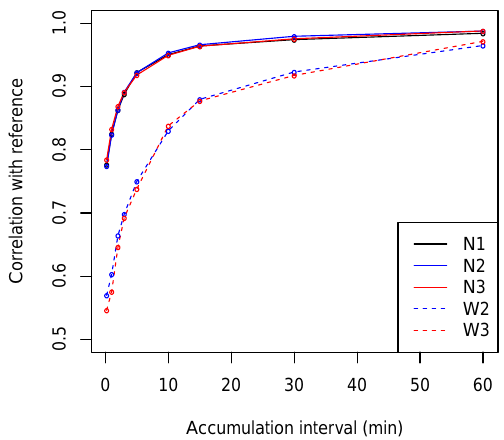
Figure 6. Correlation between rainfall measurements by Netatmo stations as obtained via personal dashboard (N1, N2 and N3), as well as those obtained via WunderMap (W2 and W3), and the pit gauge reference for various accumulation time steps.